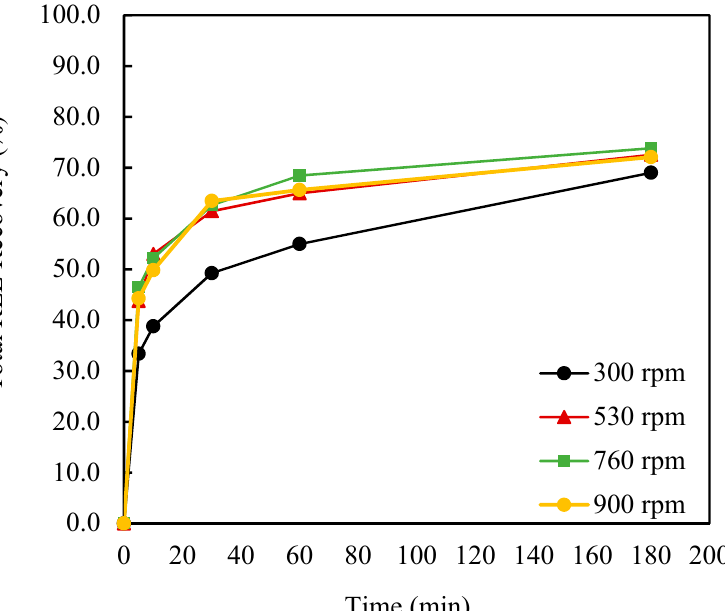
Figure 6. Effect of stirring speed on the leaching recovery of total rare earth elements contained in the Fire Clay coal middlings (75 °C, 1 M H 2 SO 4 , S/L = 10g/L, d 80 = 8.7 μ m).